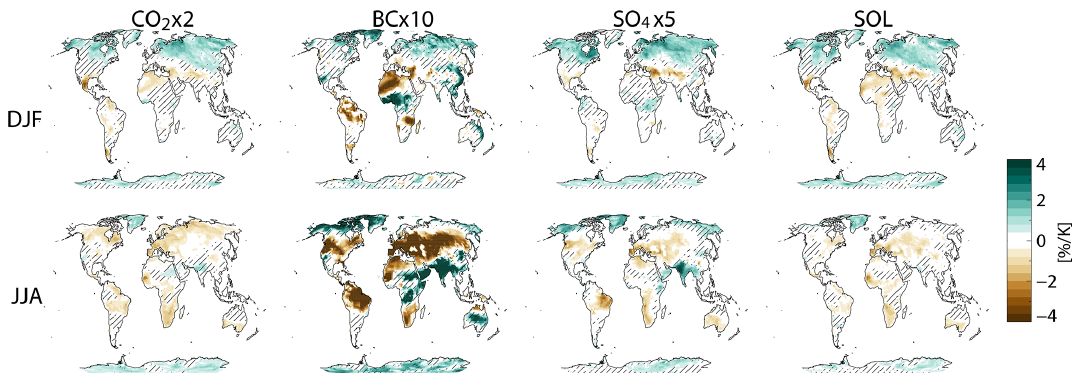
Figure 6. Multimodel median seasonal cloud cover change for the three drivers, which are normalized by the global annual mean temperature change. Hatching indicates that less than 75% of the models agree on the sign of the